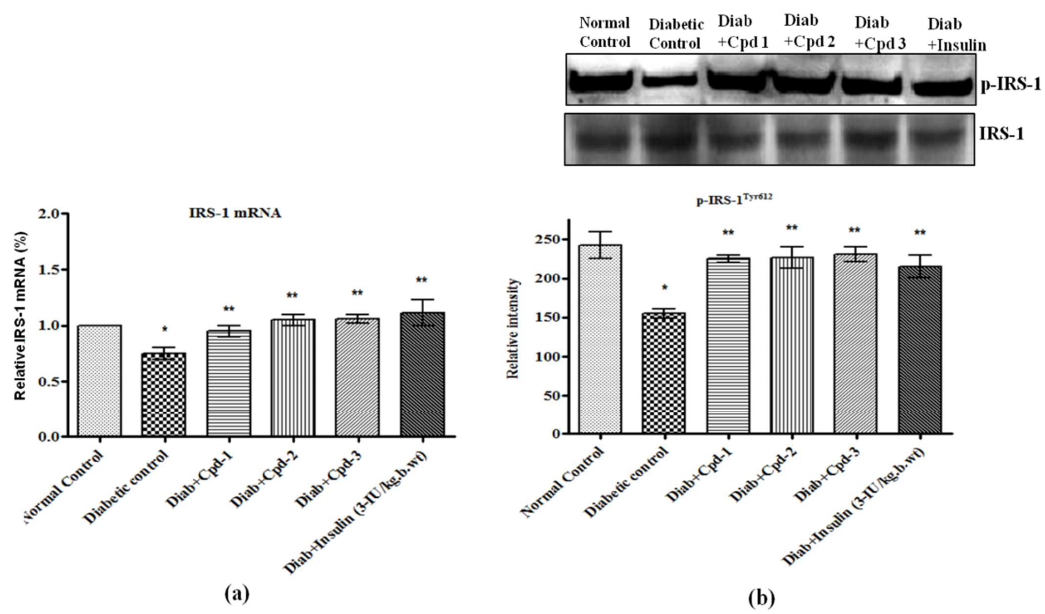
Figure 8. Effect of novel triterpenoids on ( a ) IRS-1 mRNA; ( b ) p-IRS-1 protein and expression in skeletal muscle of STZ- induced diabetic rats compared with the effect of insulin. The expression of mRNA and proteins was assessed by real-time PCR and Western blotting. β-actin was used as a loading control. Each bar represents mean ± SEM of 3 observations representing 6 animals. Significance at p < 0.05; *, compared with control, **, compared with diabetic control.